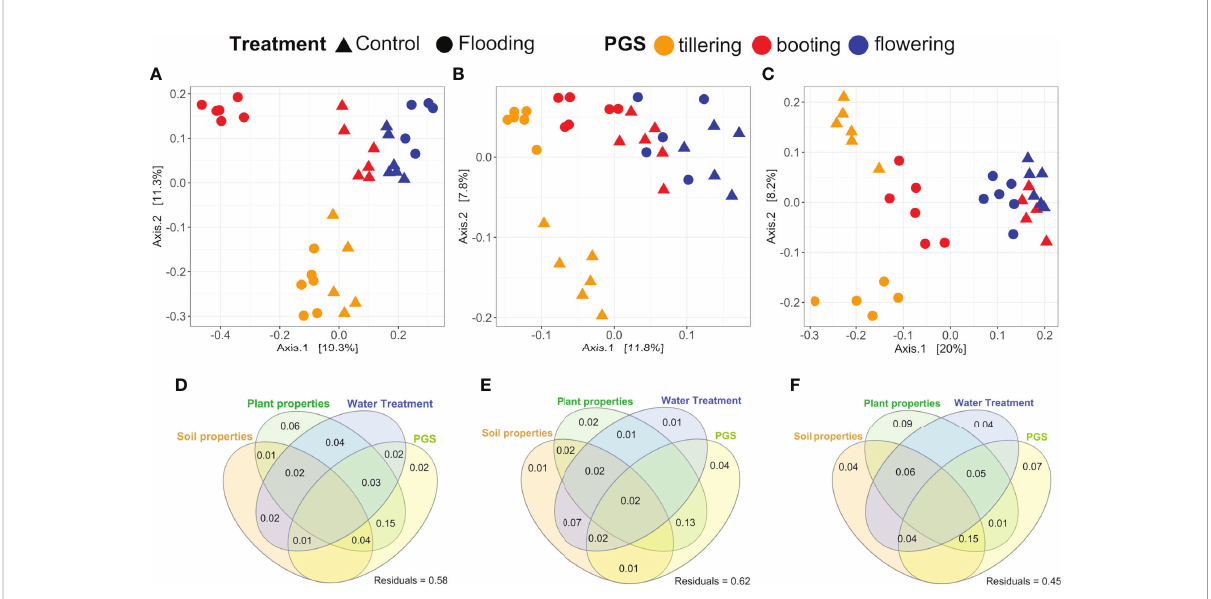
FIGURE 3 Effect of the experimental variables on the spring wheat-mycobiota complex. Principal coordinates analysis (PCoA) of the mycobiota detected in the (A) leaf, (B) rhizosphere and (C) root compartments. Variance partitioning analysis illustrating the effects of soil parameters, plant traits, watering treatment and plant growth stage (PGS) on the mycobiota associated with the (D) leaf, (E) rhizosphere and (F) root